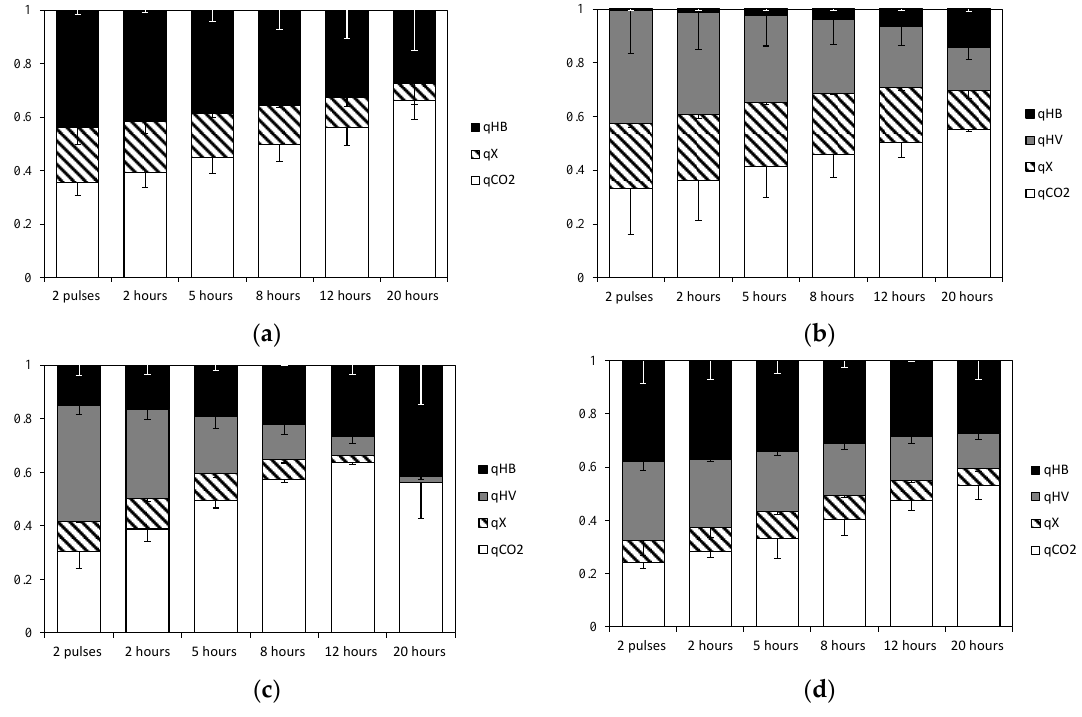
Figure 4. Carbon flux distribution ( q PHB , q PHV , q X , q CO2 ) normalised respect to substrate uptake rate: ( a ) Experiment set 1: 100% acetic acid; ( b ) Experiment set 2: 100% propionic acid; ( c ) Experiment set 3: 50% acetic acid and 50% propionic acid fed simultaneously; and ( d ) Experiment set 4: 100% acetic acid alternating with 100% propionic acid.